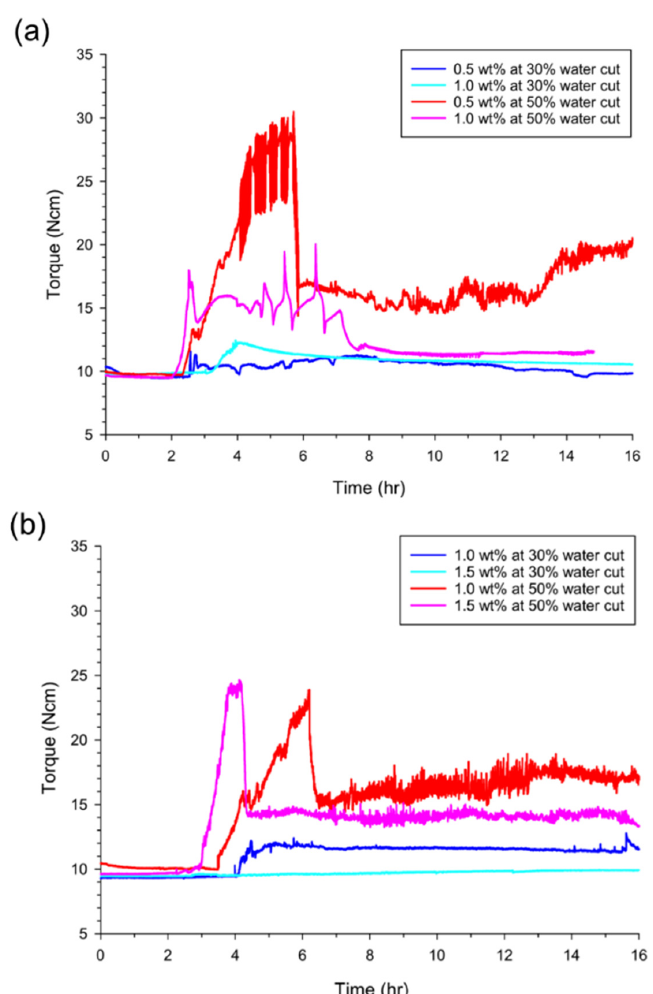
Figure 5. Anti-agglomeration e ff ects of ( a ) lecithin and ( b ) lanolin depending on the concentrations added. Hydrate formation kinetics (or rotational torques) were measured at two water cuts of 30% and 50% with two concentrations of 0.5 and 1.0 wt% for lecithin, and 1.0 and 1.5 wt% for lanolin, respectively.